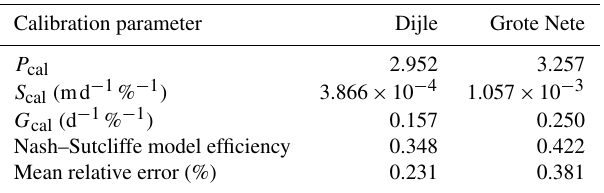
Table A4. Best-fitting parameter values, model efficiency and mean relative error (%) for the calibrated parameters of